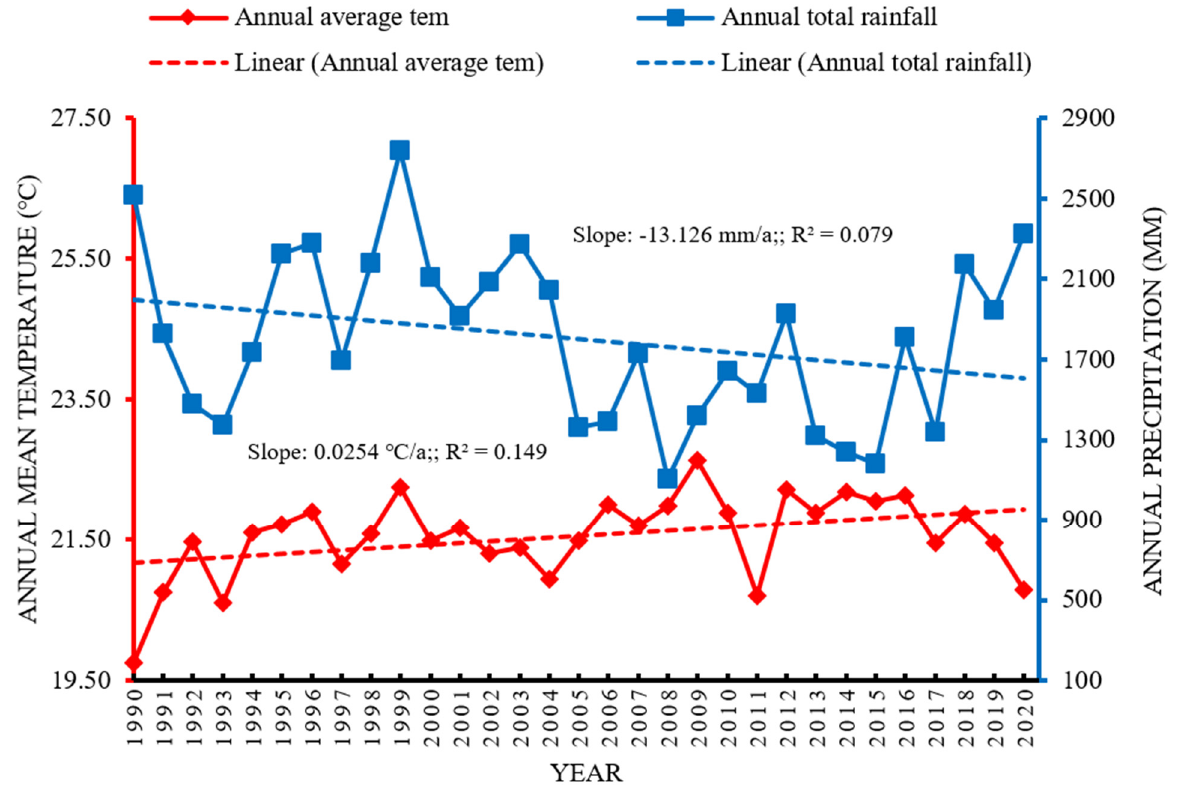
Figure 2. Temperature and precipitation trend in Mountain region of the GRB.